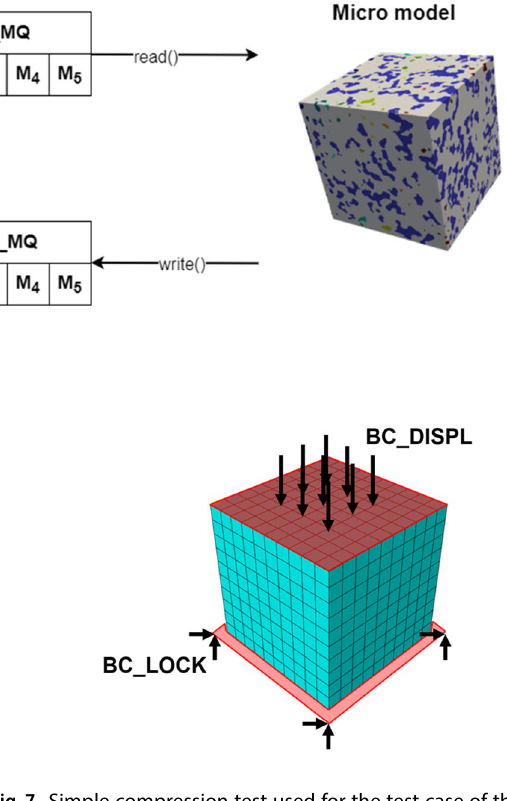
Fig. 7 Simple compression test used for the test case of the imple- mented communication